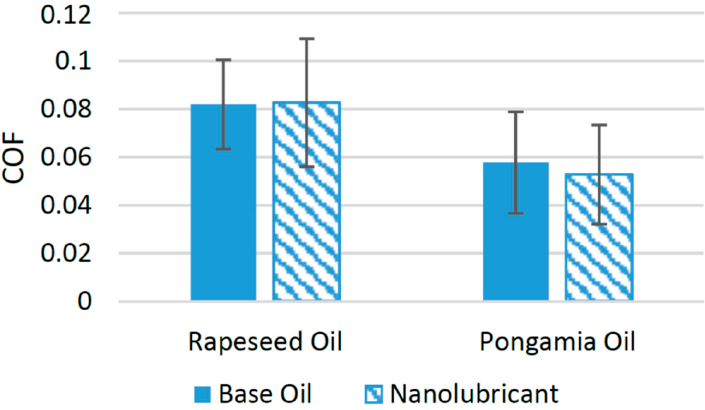
Figure 14. Effect of TiO 2 NPs on the friction performance of bio-lubricants.